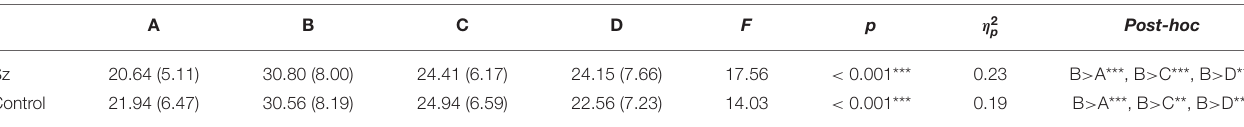
TABLE 3 | Four-deck format patterns in Sz and control.